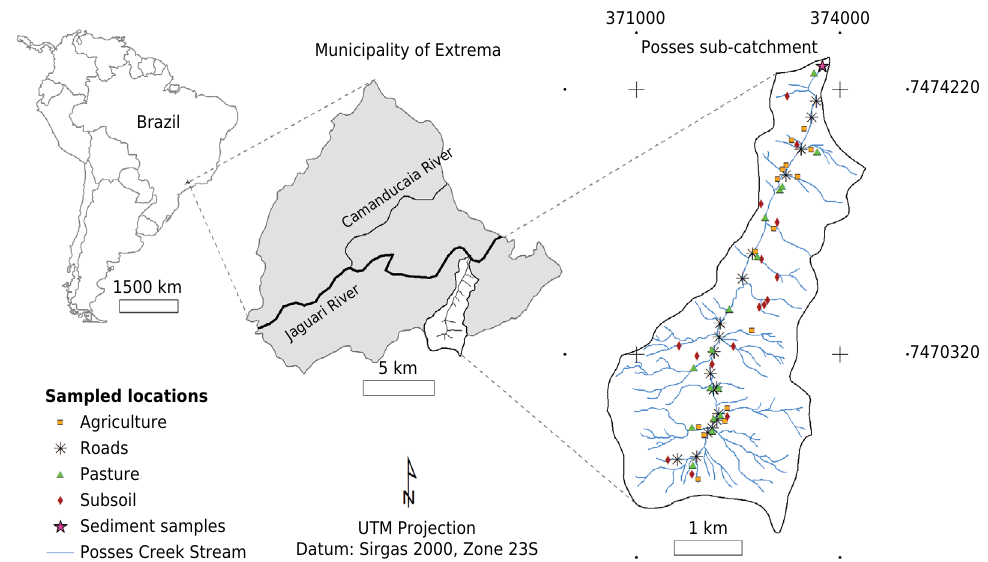
Figure 1. Geographic location of the Posses catchment and the collection points of samples of sources and sediments used in the fingerprinting study.